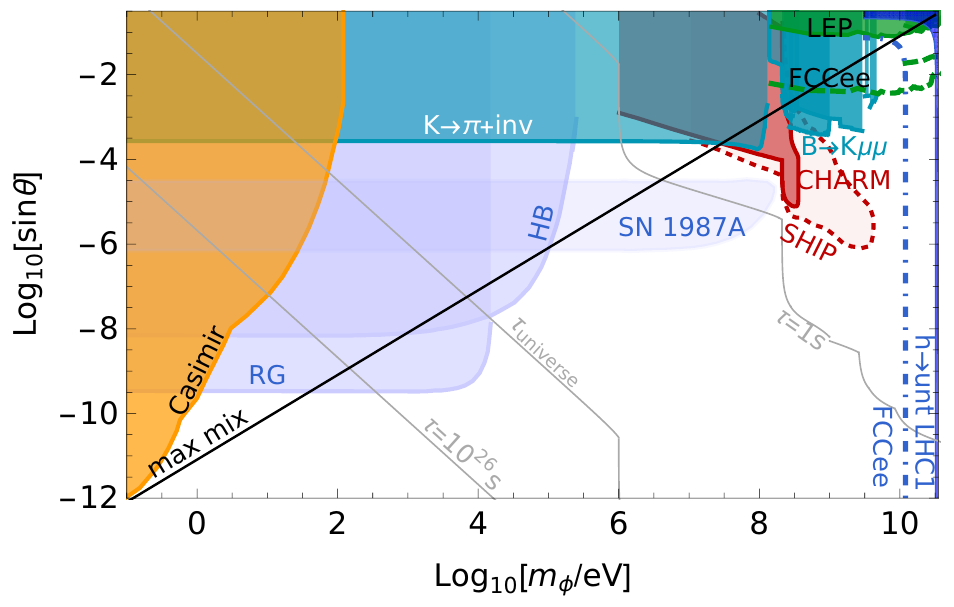
Figure 1 . Summary of present bounds and few projections on the relaxion mass m (cid:30) and the mixing angle sin (cid:18) (for details see ref. [12]): (cid:12)fth force via the Casimir e(cid:11)ect (orange) [47, 48], astrophysical probes (light blue) [57{62] such as red giants (RG), horizontal branch stars (HB) and the Supernova (SN) 1987A, rare meson decays (turquoise) where the strongest bounds stem from K ! (cid:25) + invisible at E949 [66], K L ! (cid:25)l + l (cid:0) at KTeV/E799 [72, 73] and B ! K(cid:22) + (cid:22) (cid:0) at LHCb [67, 68]. Beam dump experiment for (cid:30) production from K - and B -decays at CHARM [63{ 65] and a projection from SHiP [74] (red dotted). Constraints from the (cid:30)Z interaction (green) via Z ! Z (cid:3) (cid:30) and e + e (cid:0) ! Z(cid:30) at LEP [69, 70] and projections for the same processes at the FCCee (green dashed). Untagged Higgs decays (blue) at the LHC Run-1 [12] and projections for the FCCee and TeraZ (blue, dash-dotted, see section 4.1.1). The gray contours of the relaxion lifetime of (cid:28) (cid:30) = 1 s, 10 17 s and 10 26 s indicate the beginning of BBN, the lifetime of the universe and safety from constraints of extragalactic background light, respectively. The black line shows the upper bound on the mixing according to eq.